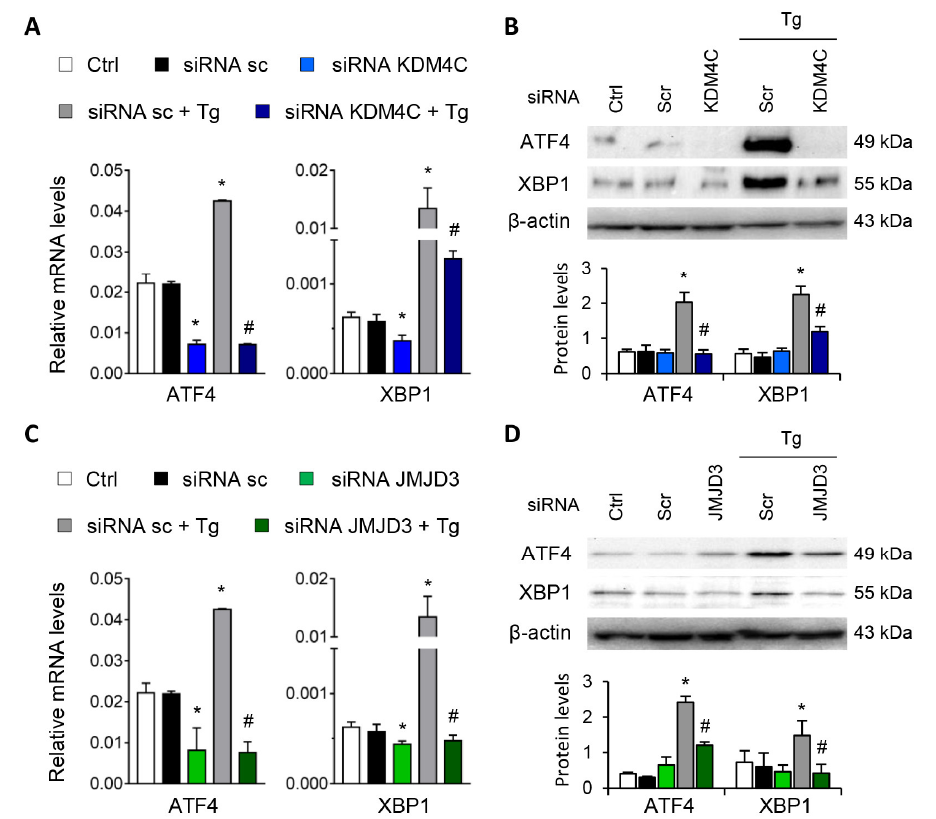
Figure 7. Specific inhibition of KDM4C and JMJD3 limits the ATF4 and XBP1 overexpression induced by UPR activation . HK-2 cells were transfected with specific KDM4C siRNA ( A , B ), JMJD3 siRNA ( C , D ), or nonspecific scramble (Scr) siRNA (80 nM) for 48 h. Tg (4 µ M) was then added in the final 24 h to induce UPR activation. Gene expression ( A , C ) and protein levels ( B , D ) of ATF4 and XBP1 were assayed by quantitative RT-PCR and Western blotting, respectively. GAPDH and β-actin were used as control. Results are expressed as the mean ± SEM of three independent experiments. * p < 0.05 vs. siRNA Scr; # p < 0.05 vs. siRNA Scr + Tg (cells transfected with siRNA Scr and treated with